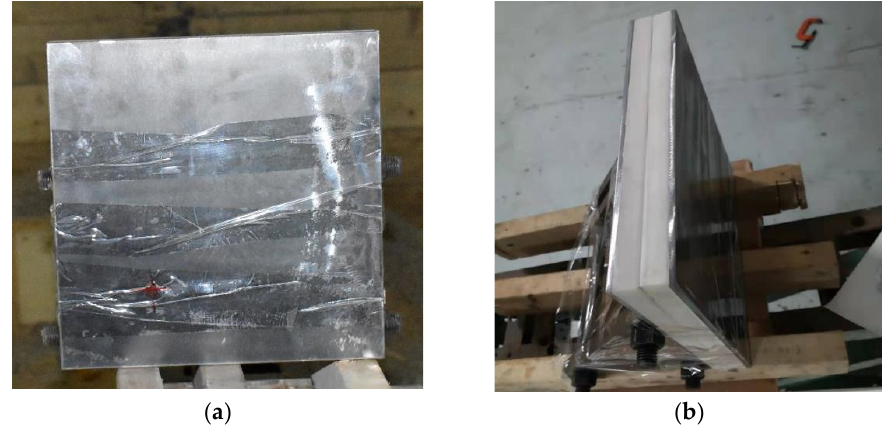
Figure 4. Photograph of the armor in the experiment. ( a ) front view. ( b ) side view.